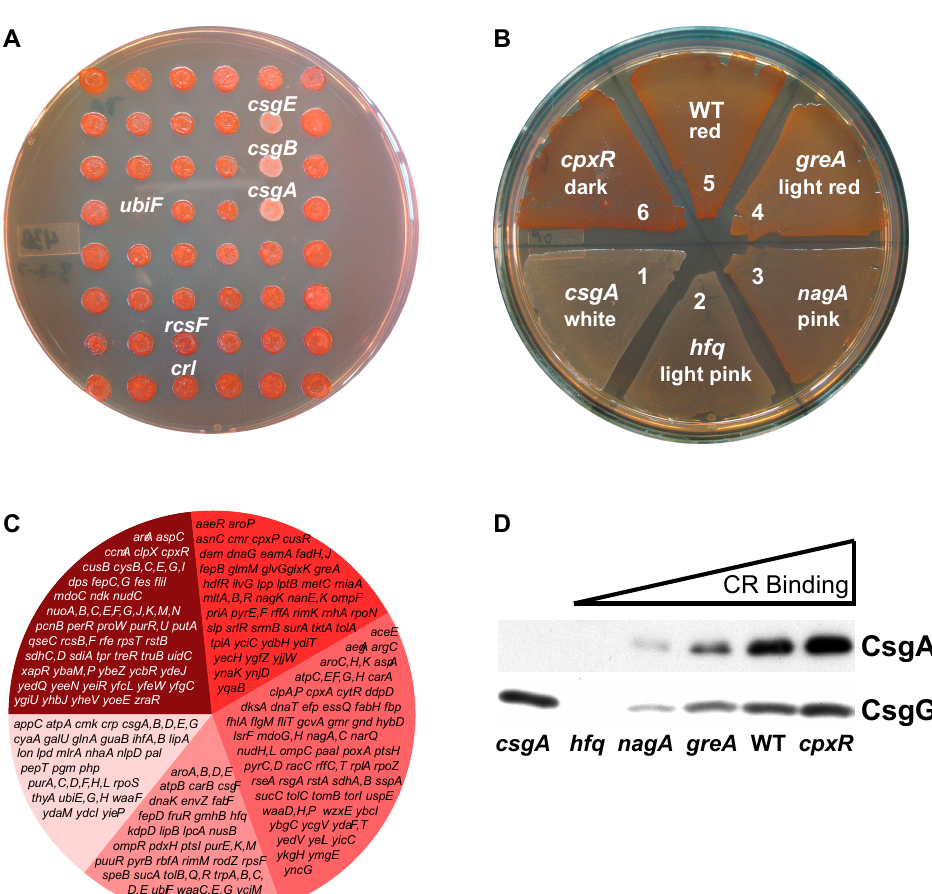
Figure 1. Overview of screen for mutants affecting curli production. ( A ) The Keio collection was screened on CR indicator plates after inoculation with a bolt replicator and incubation for two days at 26 °C. The collection was screened three times. ( B ) Associated phenotype scoring: 1 or white = csgA ; 2 or light pink = hfq ; 3 or pink = nagA ; 4 or light red = greA ; 5 or wild type (WT) = BW25113; and 6 or dark red = cpxR . ( C ) Distribution of Congo red (CR) phenotypes based on scoring from white to dark red. ( D ) Whole cell Western blots of strains probed with anti-CsgG and anti-CsgA antibodies. Strains with an altered phenotype were regrown on CR indicator plates for verification and scored numerically according to color from lightest to darkest (Figure 1B and Table S1). We isolated 332 Keio mutants with reproducible CR phenotypes. Of these, 64 strains had two or more phenotypes upon isolation of single colonies. Each genotype from these gene deletion strains was verified